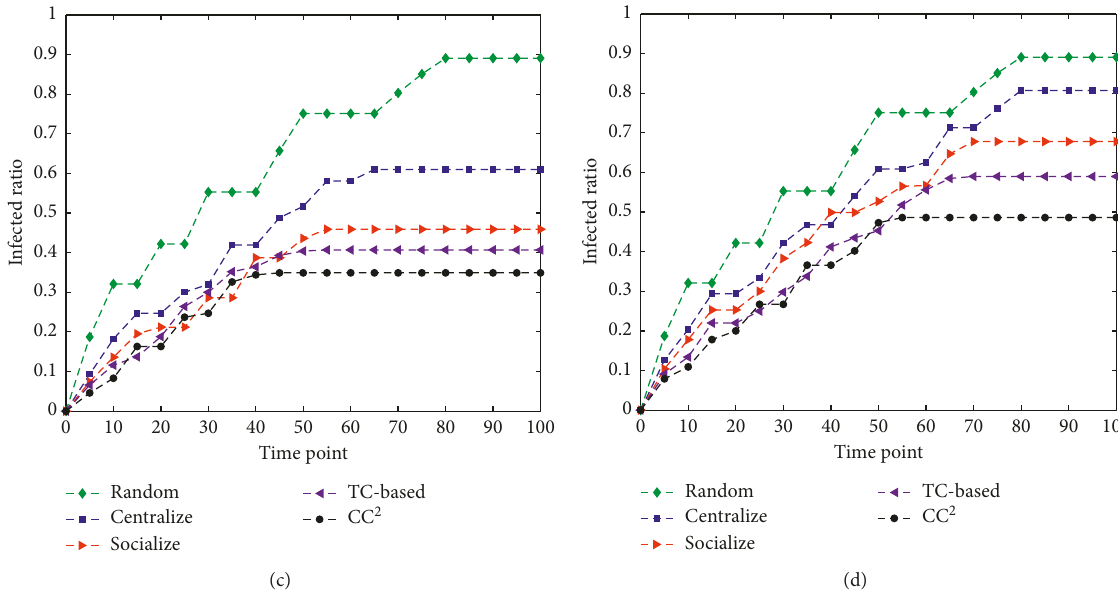
Figure 12: Performance comparison of different coping scheme with 5% patching nodes on the Haggle network with initially infected ratio μ � 5% (a), 10% (b), 15% (c), and 20% (d),